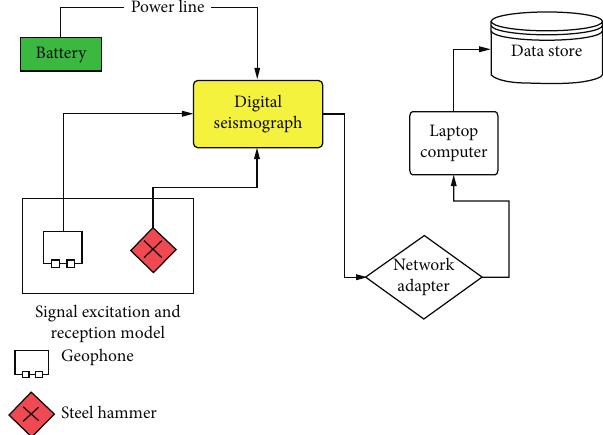
Figure 1: Composition of testing